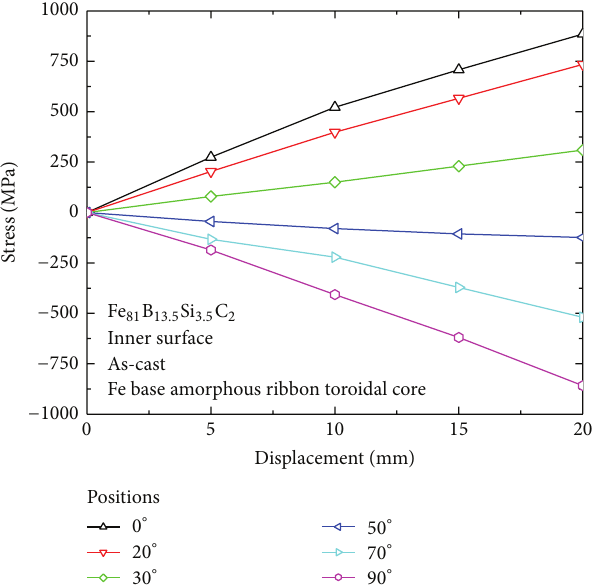
Figure 6: Stress distribution on the inner surface of the as-cast, Fe based, 0.5 mm thick, and 30 mm inner diameter amorphous toroidal transducer core for 0 ∘ , 20 ∘ , 30 ∘ , 50 ∘ , 70 ∘ , and 90 ∘ positions.